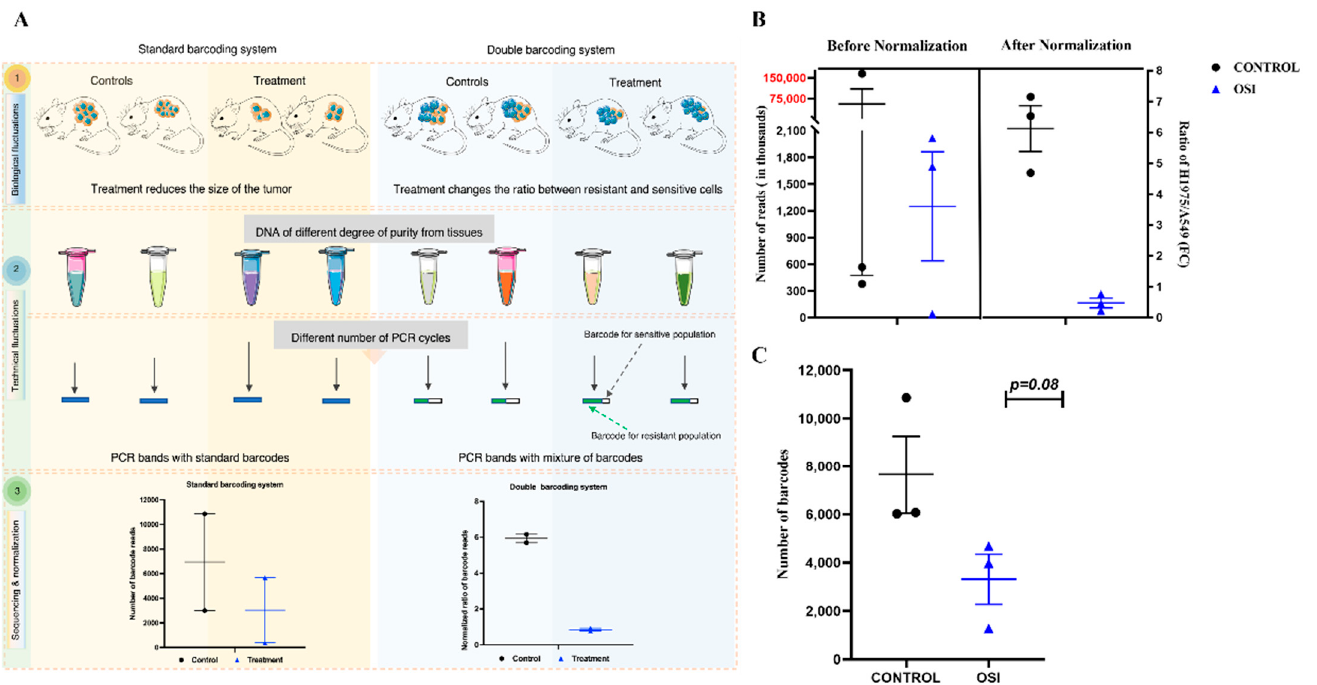
Figure 3. Comparison of standard and double-barcoding systems. ( A ) Schematic explanation of the standard- and double-barcoding systems. There are two sources of variability in counting barcodes. They include biological variabilities associated with differences in cell injections and their ability to form tumors and metastasis in different animals; and technical variability associated with differences between different samples in tissue disruption and DNA isolation, which significantly affect the efficiency of isolation of barcodes for sequencing. (Left panel) shows experiment with standard barcoding. Barcoded cells form tumors and metastasis in control group with certain variability, and these tumors and metastasis might be smaller (and fewer in case of mets) in drug-treated animals. DNA isolated from these animals will be of different quality and different number of PCR cycles will be necessary to amplify sufficient for sequencing amounts of barcode DNA bands (visible bands are needed). Correcting the number of reads after sequencing for tumor sizes and the number of PCR cycles creates enormous variabilities, which makes comparison of control and drug-treated groups almost impossible. Similar is true with metastasis. The only reasonable comparison could be done with the number of clones (number of different barcodes), but this parameter is insufficient for evaluation of drug effects (see the example with osimertinib below). (Right panel) shows exper- iment with double barcoding. Drug-sensitive and drug-resistant cells are barcoded by two different double-barcoding libraries and co-injected into animals in equal amounts. Both cell populations form mixed tumors and both metastasize to distinct organs. Due to the difference in animals, there is certain variability in tumor sizes, but the relative representation of two cell types in the tumor has low variability. The same is true for metastasis. In the drug-treated group the sizes of tumors do not become smaller because of the presence of the drug-resistant cells. They expand, while the drug- sensitive cells contact. The ratio between the lines changes, and such a ratio also has low variability. DNA isolated from these animals will be of different quality, and different number of PCR cycles will be necessary to amplify sufficient for sequencing amounts of barcode DNA bands. However, bands containing barcodes for both lines are amplified together from the same DNA, and therefore their ratio remains unchanged independently on the number of PCR cycles. Similar is true with metastasis. Therefore, double barcoding diminishes both biological and technical variations and al- lows quantification not only of the number of clones but also of their sizes. ( B ) Comparison of raw numbers of reads (of barcode 1, reflecting the number of H1975 cells in tumors) in mice treated and untreated with osimertinib with normalized number of reads in the same samples. ( C ) Comparison of the number of clones (barcodes 2) in control and osimertinib-treated group. The experiment shows that upon using standard barcoding without normalization on drug-resistant cells, quantifi- cation of effects of some drugs becomes practically impossible.